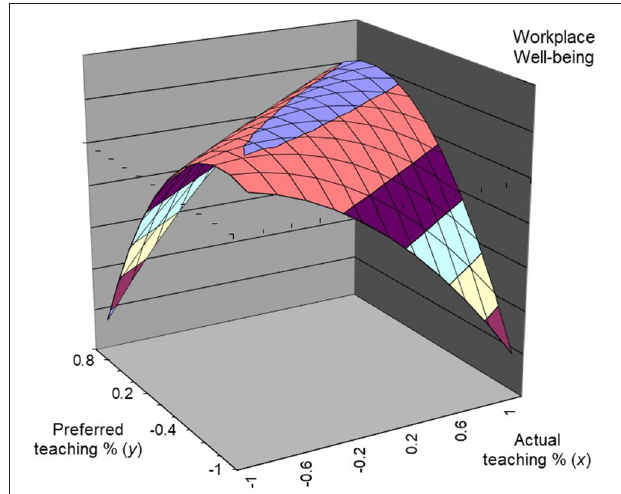
FIGURE 1 | Effects of actual and preferred research time allocation on workplace well-being.